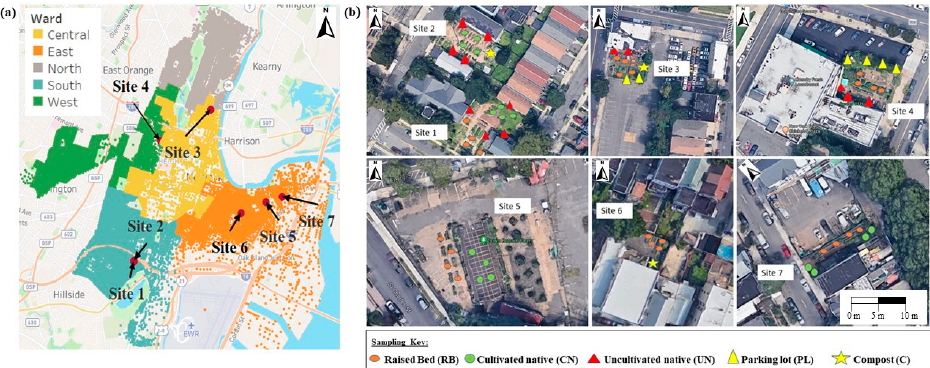
Figure 1. Community farm research sites in Newark, NJ, USA represented by ( a ) ward; ( b ) sampling scheme and sample category. Table 1. Select characteristics of Newark, NJ, USA community farms selected for sampling, including types of areas cultivated and availability of on-site composting.